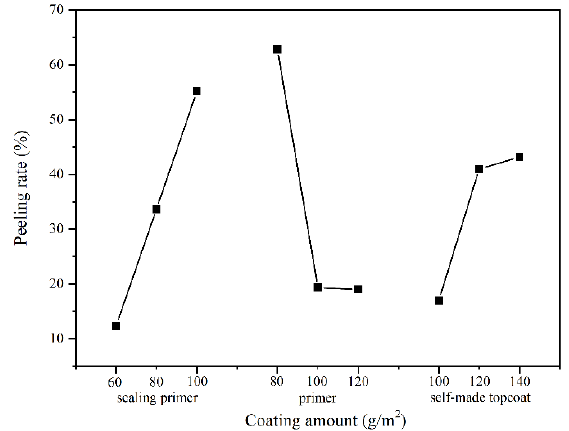
Figure 9. Visual analysis of the film’s peeling rate. Table 5. Variance analysis of the adhesion of the